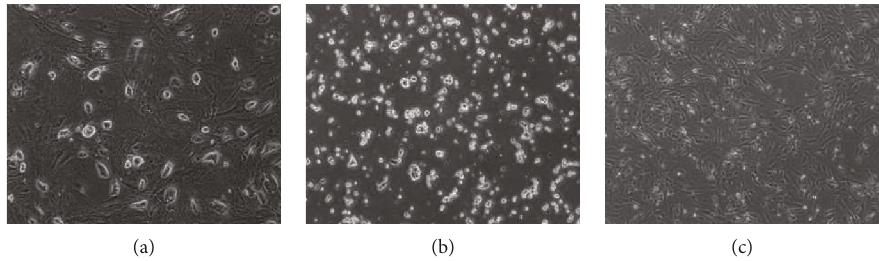
Figure 2: Mouse embryonic stem cells, embryonic carcinoma cells, and embryonic fi broblasts used in the experiments: (a) ES-E14TG2a mouse embryonic stem cells; (b) P19 mouse embryonic carcinoma cells; (c) mouse embryonic fi